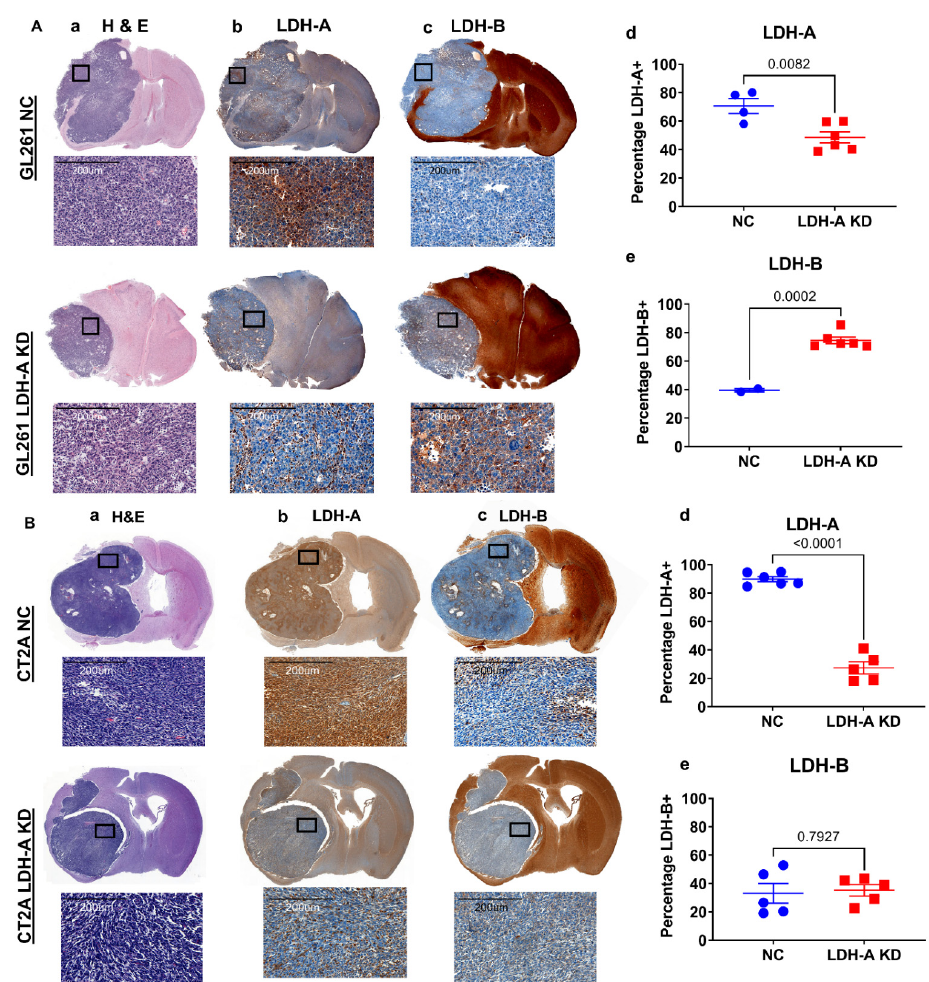
Figure 4. LDH-A and LDH-B immunohistochemistry of i.c. GL261 and CT2A gliomas. H&E staining for GL261 ( Aa ) and CT2A ( Ba ) i.c. tumors (both NC and LDH-A KD); corresponding LDH-A ( Ab , Bb ) and LDH-B ( Ac , Bc ) immunohistochemistry. The 4 sets of i.c. tumors were grown in immunocompetent C57BL/6 mice. Quantification of percentage of tumor-cell staining (Weka segmentation analysis) for LDH-A ( Ad , Bd ) and LDH-B ( Ae , Be ) is shown in Ad, Ae, Bd, and Be; mean ±